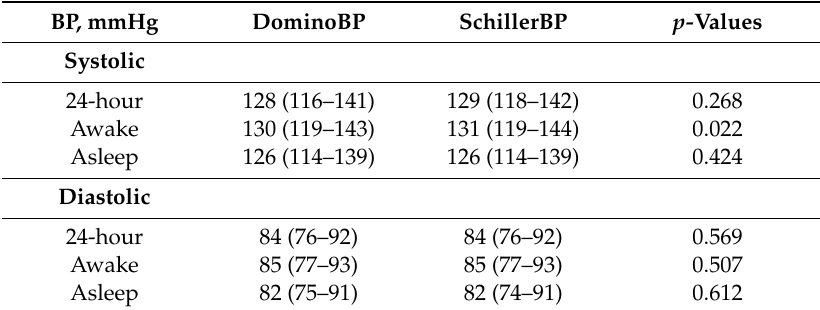
Table 4. Comparison of 24-hour, awake, asleep blood pressure values calculated with the DominoBP and SchillerBP